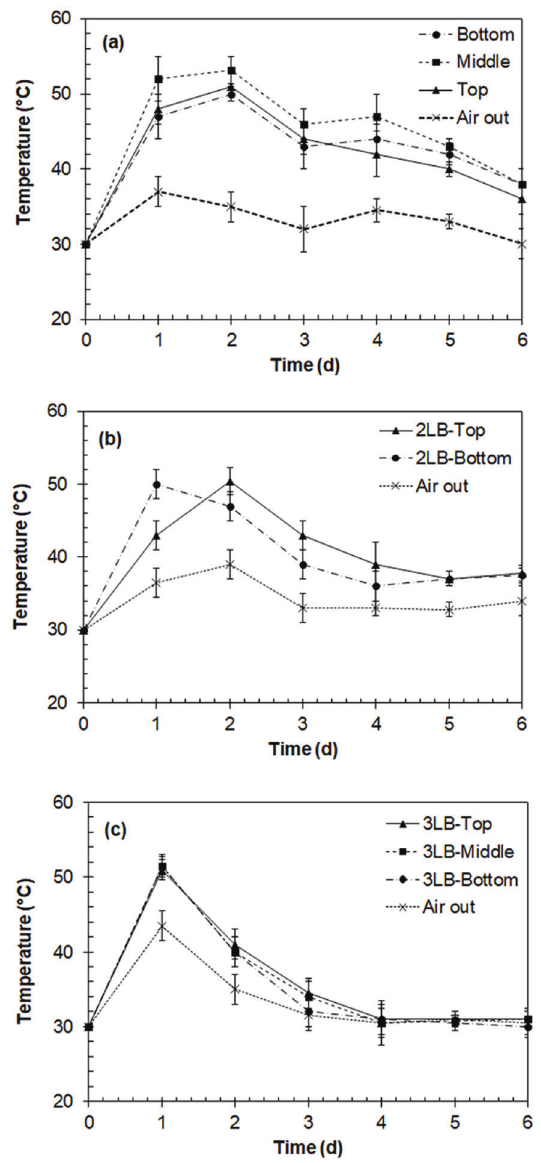
Fig. 2 – Temperatures of beds and outlet air during SSF of A. niger (a) control packed-bed bioreactor, cB; (b) Two-layered packed-bed bioreactor, 2lB; (c) Three-layered packed-bed bio - reactor,